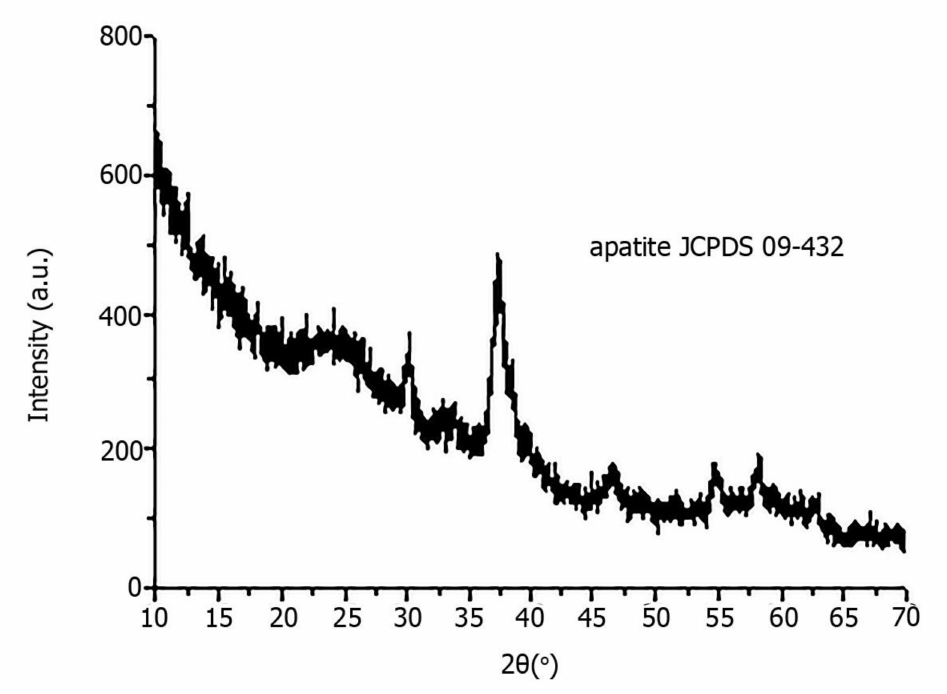
Figure 5. X-ray diffraction of pathological biomineral of ovarian tumor (sample 23).